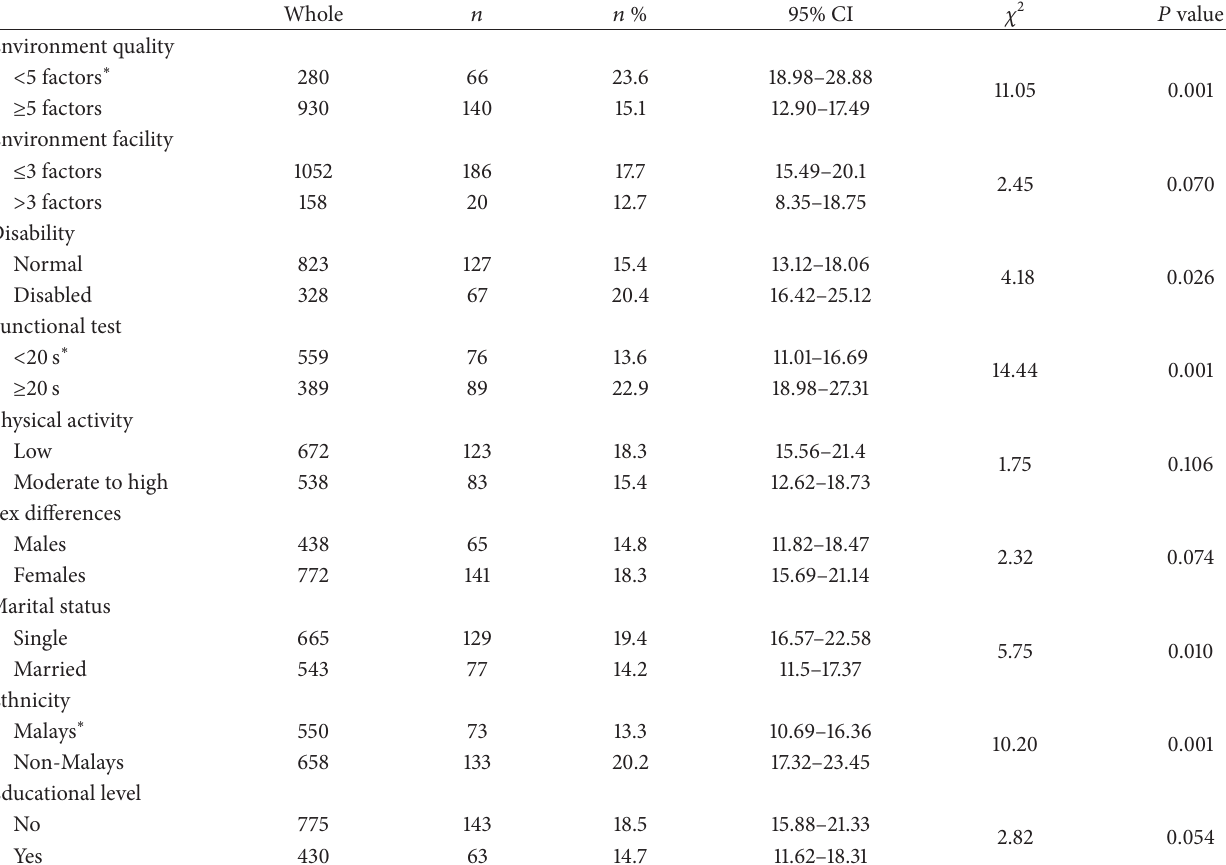
Table 2: Prevalence of falls and associations with sociodemographic factors.